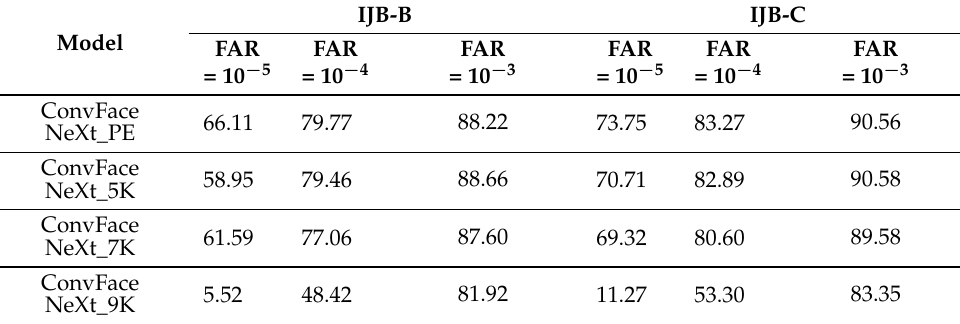
Table 7. Verification accuracy of different kernel sizes on IJB-B and IJB-C datasets.